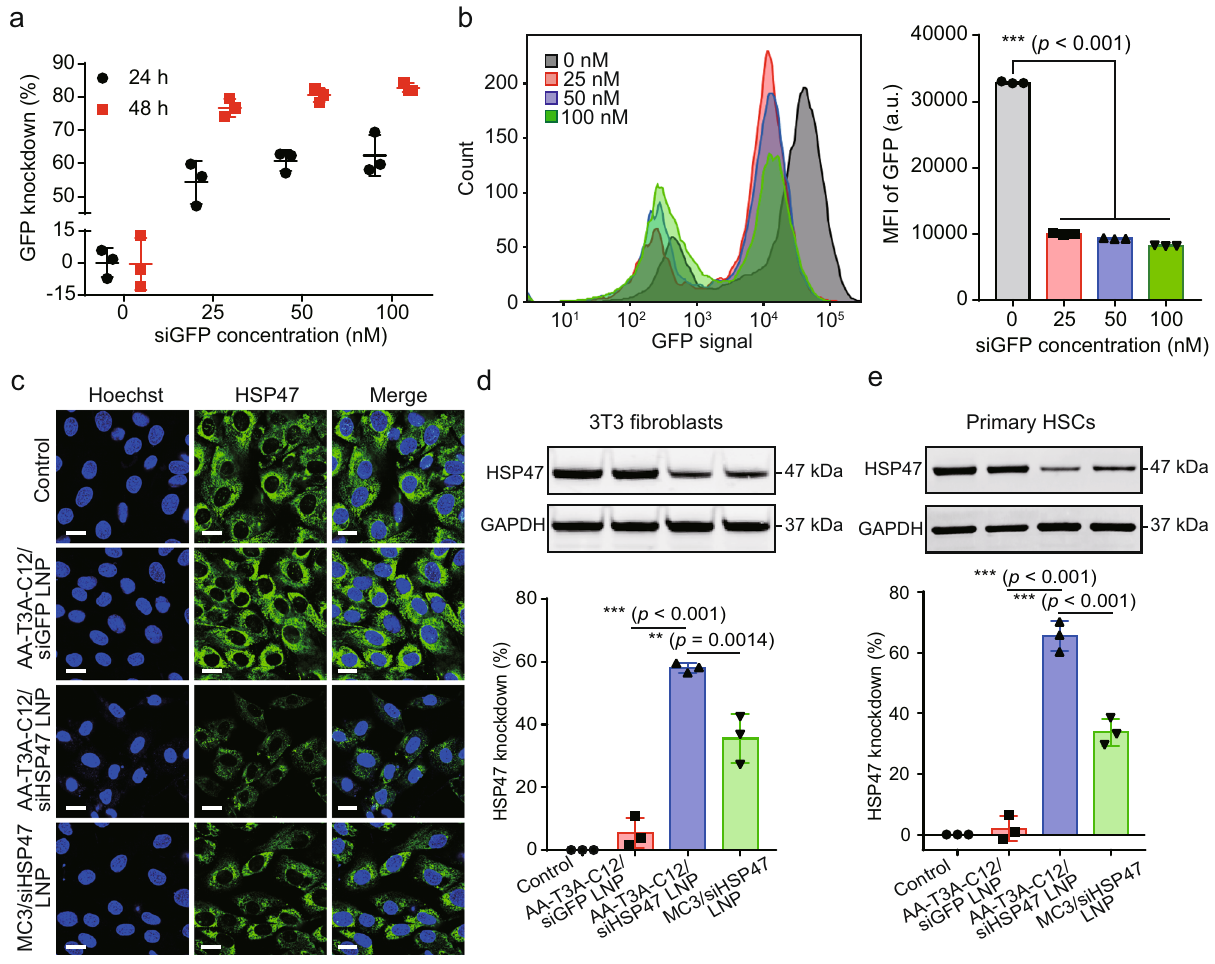
fi broblasts. Scale bar: 20 μ m. d and e Western blot analysisof HSP47 expression in LNP-treated activated 3T3 fi broblasts and primary HSCs (representative dataset from n